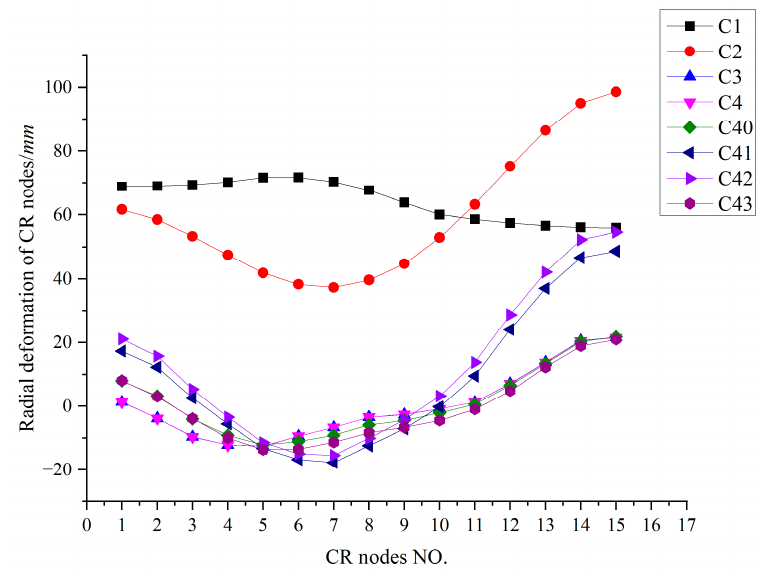
Figure 47. CR radial deformation curve (mm).